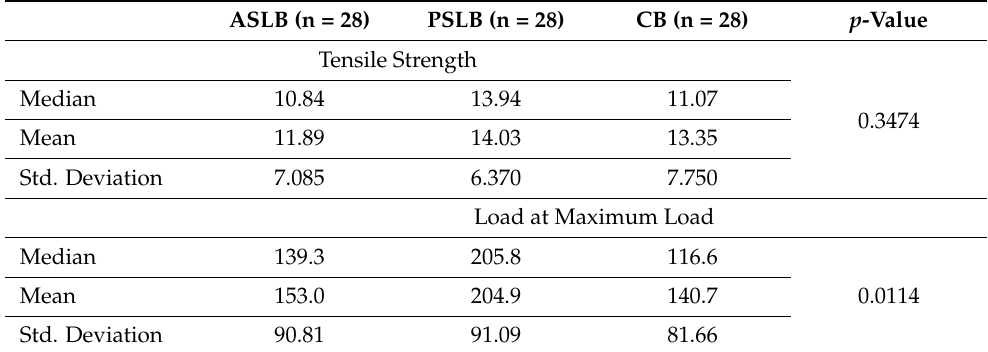
Table 3. Mean, Median and SD.